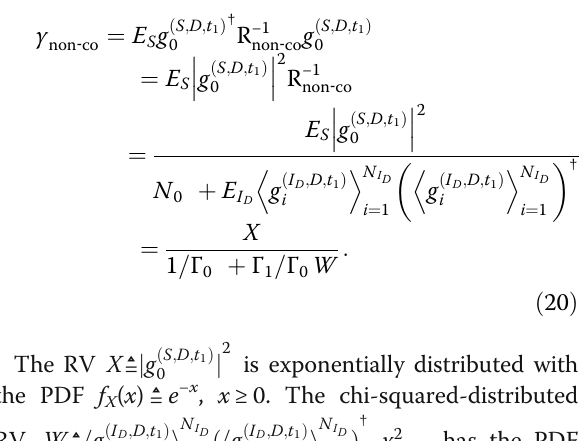
¼ ð 2 N Þ E and E total I D I D , where the factor 2 represents I D two time slots. The correlation coefficients are explained as follows: the smaller the r is, the larger the distance SR between the source node and the relay node is. On the other hand, the smaller the r I is, the more independent, D i.e., the less correlated, the two channel